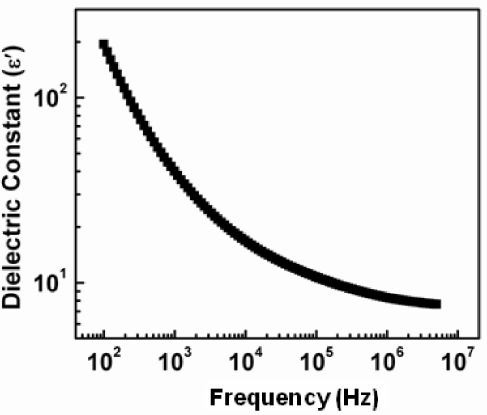
Figure 5. Dielectric constant behavior of synthesized NiS along with a change in frequency.